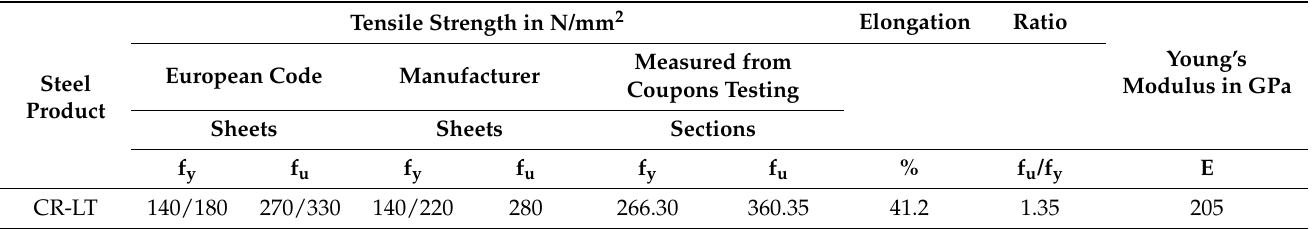
Table 1. Material properties obtained from the tensile coupon